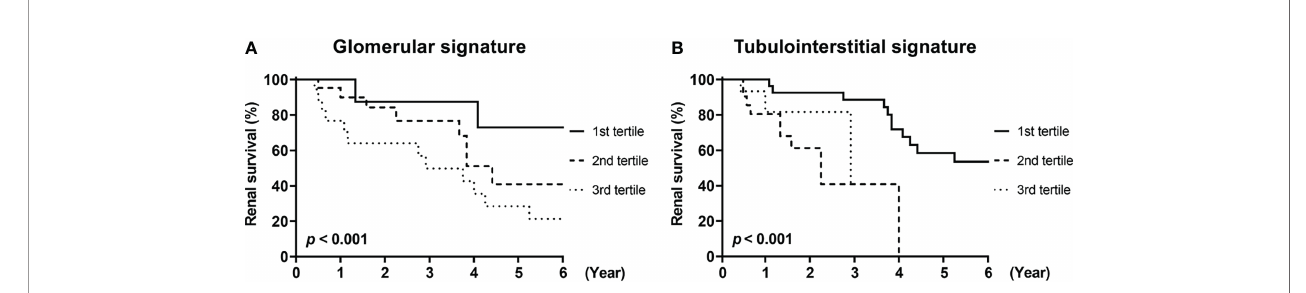
FIGURE 5 | Renal survival of patients with diabetic kidney disease according to compartmental mRNA signatures. (A, B) The renal survival of patients with diabetic kidney disease according to the tertiles of (A) glomerular and (B) tubulointerstitial mRNA signatures are shown. Each signature was generated from the integration of mRNAs differentially expressed in corresponding compartments ( NNMT, THBS2, SPON2, COL3A1, COL1A1 for glomerular signature and LYZ, C3, FKBP5, G6PC for tubulointerstitial signature). p < 0.001 for both comparisons by log-rank test.